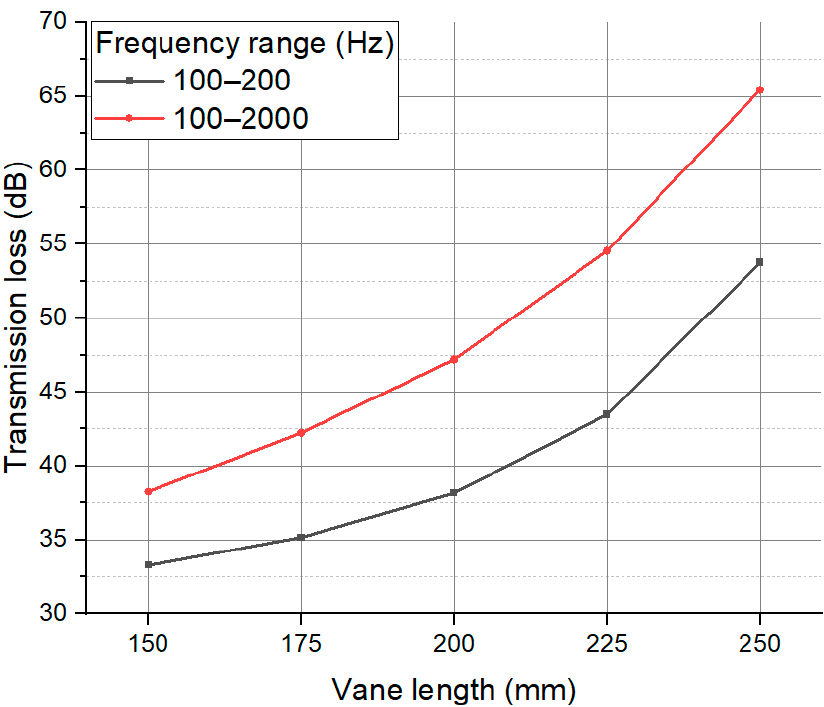
Figure 21. Average transmission loss according to the vane length in the outer vane reverse type.